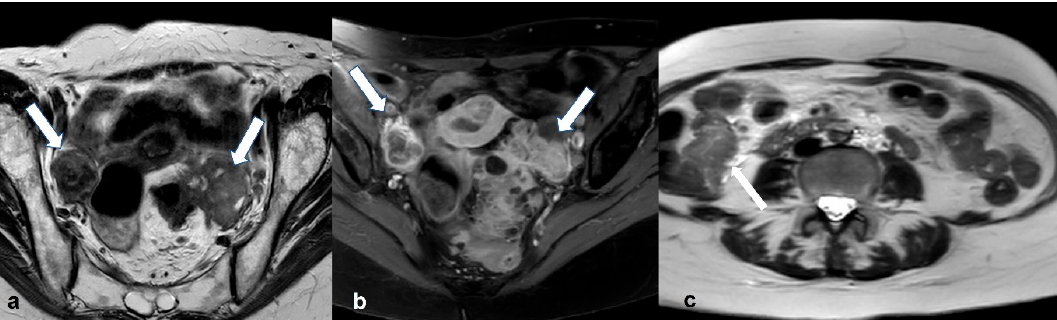
Figure 22. Bilateral ovarian metastases (Krukenberg tumors) from colon cancer. Τ 2 weighted axial image ( a ) shows bilateral ovarian soft-tissue masses (( a ),arrows) exhibiting inhomogeneous en- hancement on corresponding T1 weighted FS CE image (( b ), arrows). Axial T2 weighted image ( c ) of the upper abdomen of the same patient shows extensive circumferential wall thickening of the ascending colon (arrows).